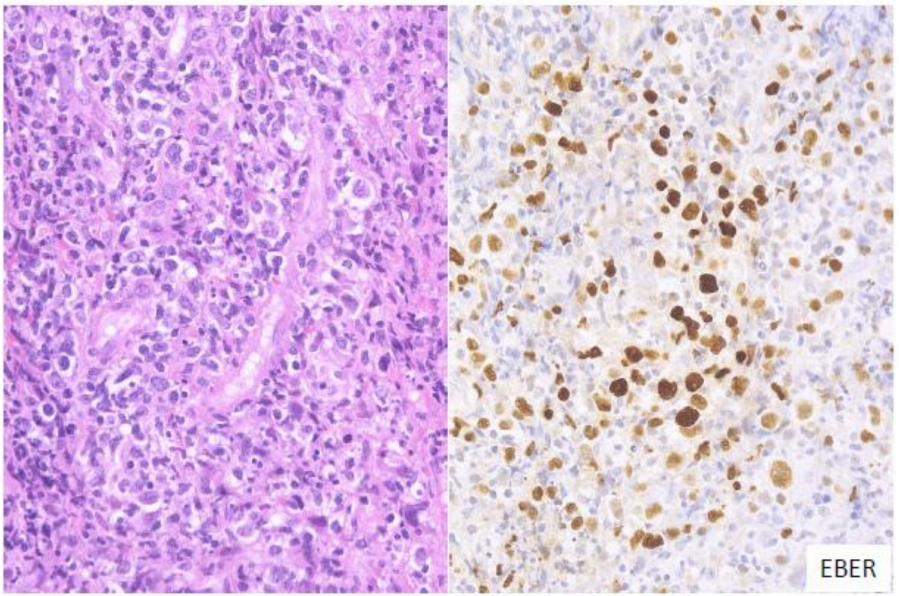
Figure 2. Pathologic findings for polymorphous EBVMCU. A tonsillar EBVMCU in a patient un- dergoing methotrexate treatment. Atypical lymphoid cells with polymorphous morphology and angioinvasion are seen, and are positive for EBV-encoded small RNA (EBER) (HE and EBER staining; magnification, × 400).